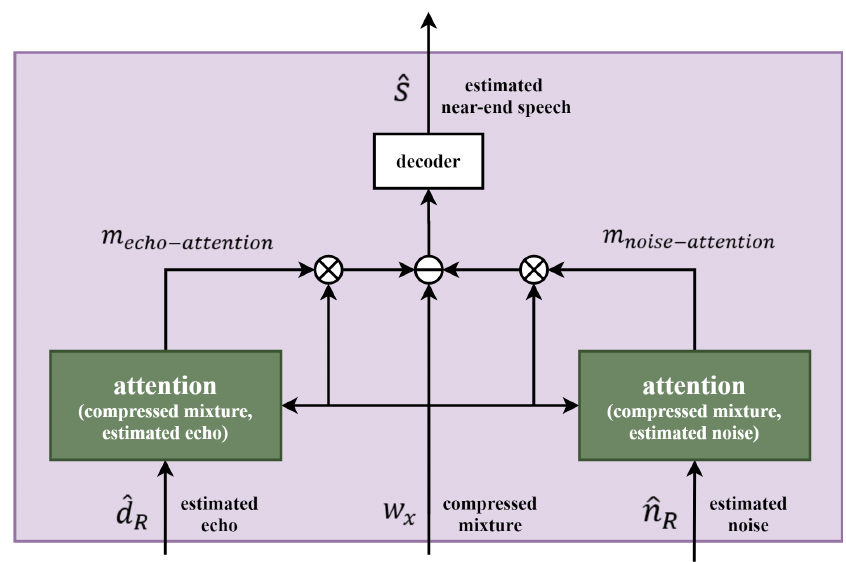
Figure 5. Decoder and mask for estimating near-end speech with attention